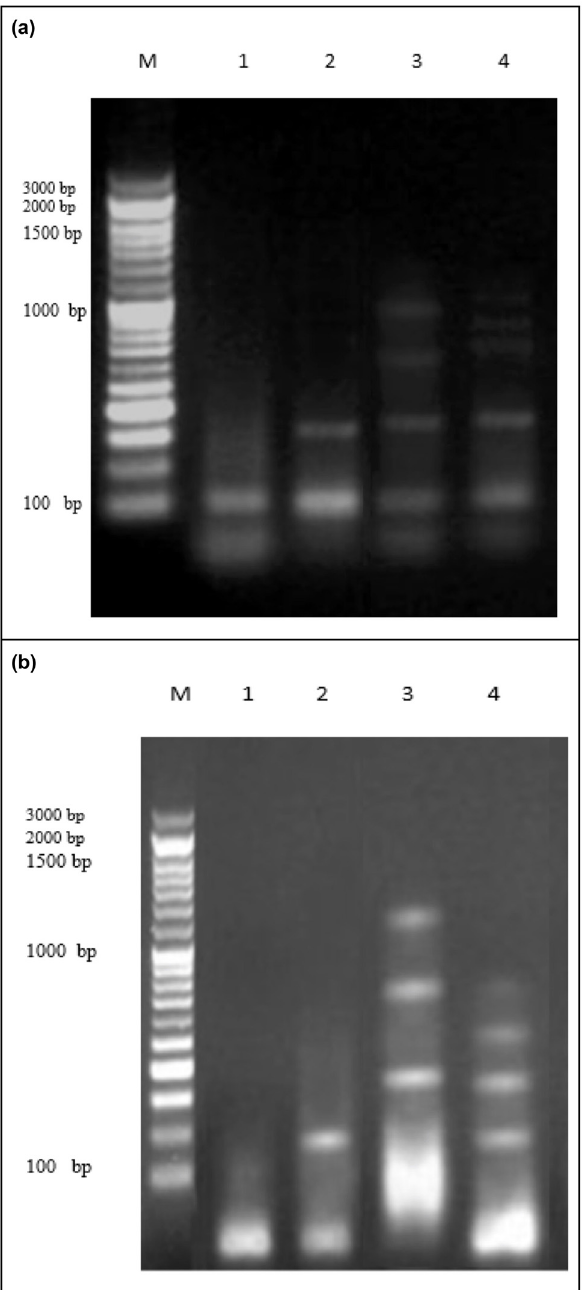
Figure 6: ( a ) DNA fragmentation detected with agarose gel in lung cancer cell lines treated with SFB, SFB - NPs, DOX. M: represent DNA marker, lanes 1: represents cancer cell lines ( − ve ) , lane 2: repre - sents SFB - A549, lane 3: represents SFB - NPs - A549, lane 4: repre - sents DOX (+ ve ) cancer. ( b ) DNA fragmentation detected with agarose gel in breast cancer cell lines treated with SFB, SFB - NPs, Tam. M: represent DNA marker, lanes 1: represents cancer cell lines ( − ve ) , lane 2: represents SFB, lane 3: represents SFB - NPs, lane 4: represents Tam (+ ve ) MCF -